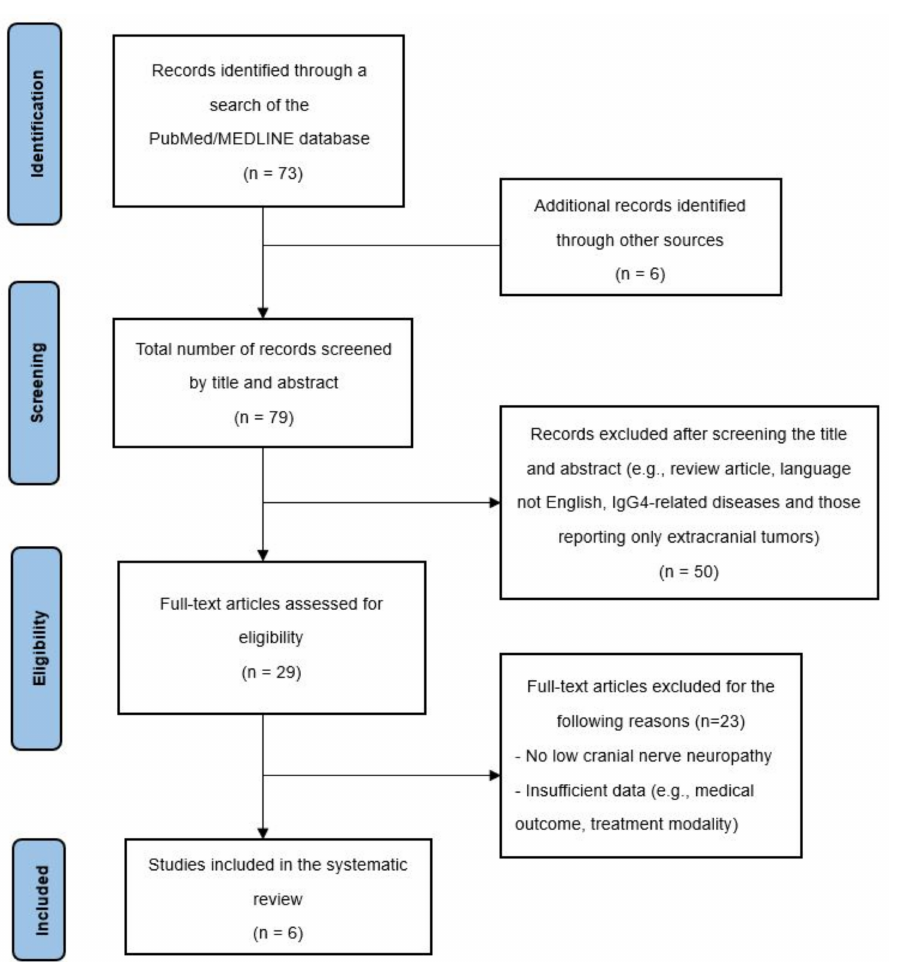
Figure 6. PRISMA diagram describing the case selection